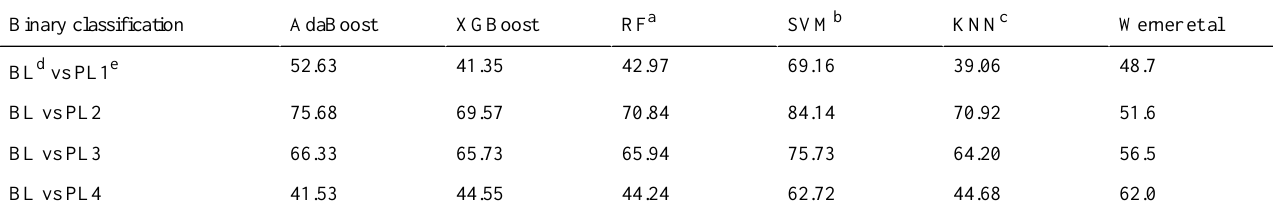
Table 6. Validation accuracy of BioVid features.